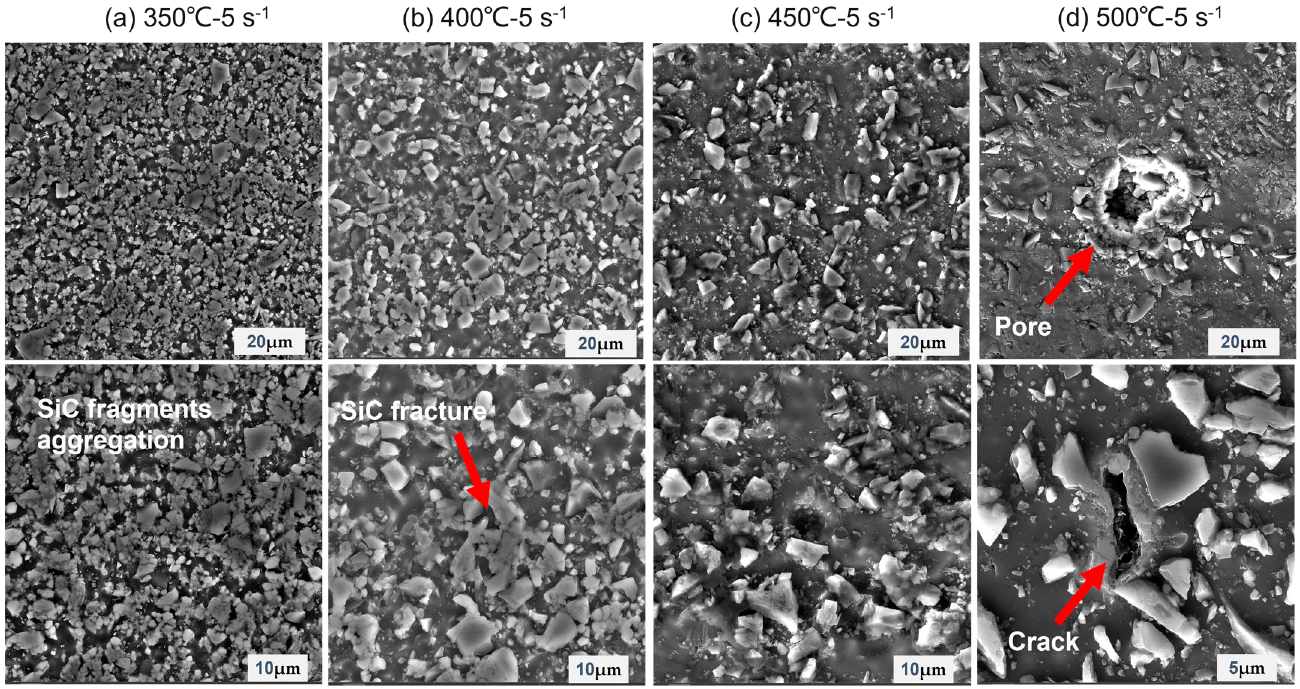
Figure 7. SEM images of the SiCp/6013 composites for instability zones at a strain of 0.7: ( a ) 350 °C-5 s − 1 ; ( b ) 400 °C-5 s − 1 ; ( c ) 450 °C-5 s − 1 ; ( d ) 500 °C-5 s − 1 .